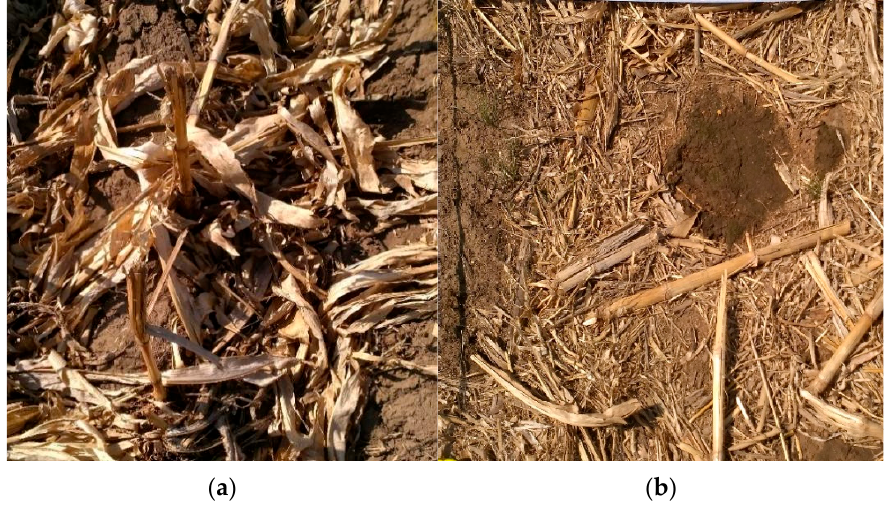
Figure 12. Examples of corn residue with shadow ( a ) and with di ff erent moisture ( b ).